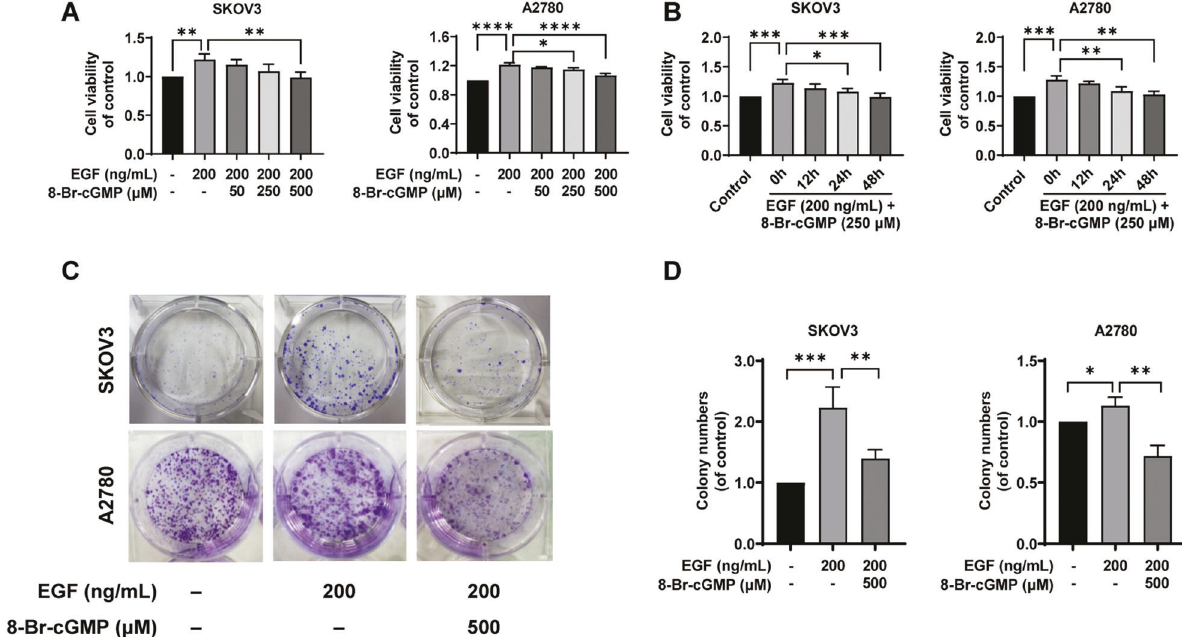
Fig. 2 Activation of PKG I attenuated EGF-induced EOC cell proliferation in vitro. A , B EOC cell proliferation was analyzed by CCK8 assays. C , D R Representative results of colony formation; the number of colonies counted was of an entire well and the error bars